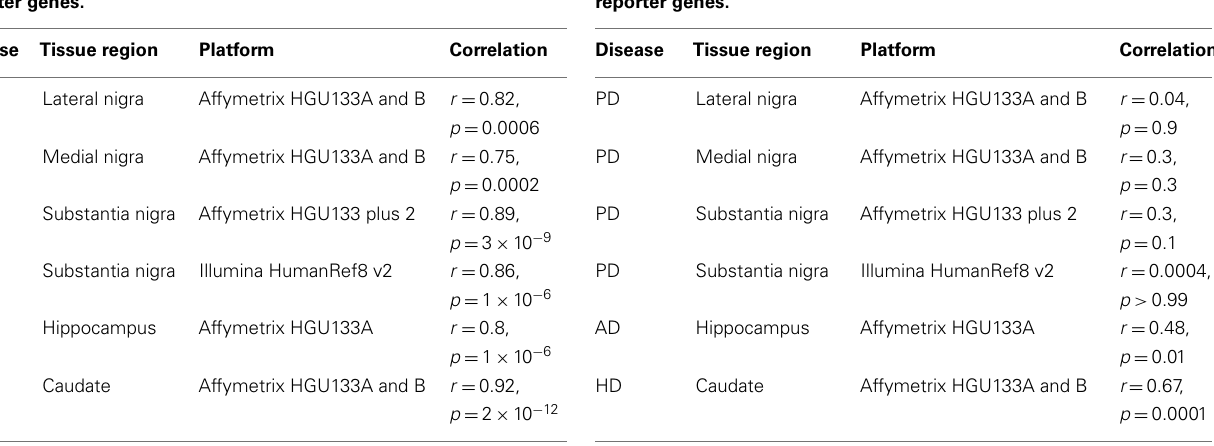
Table 4 | Correlation of X-pattern from whole tissue with astrocytic reporter